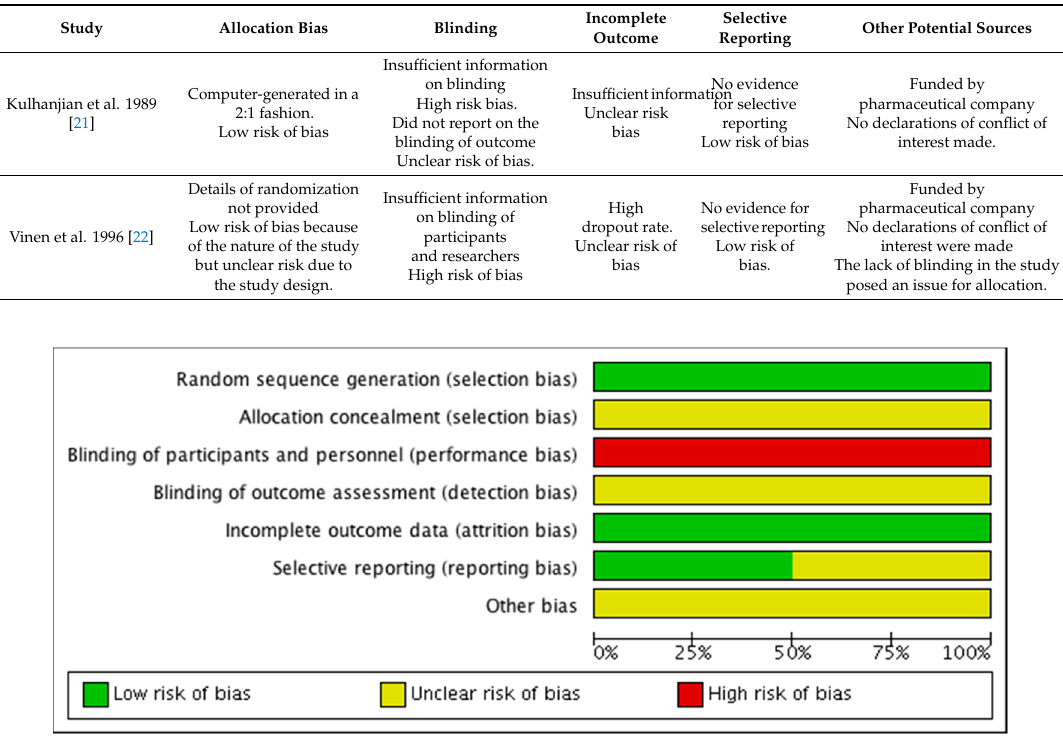
Figure 2. Risk of bias in the randomised controlled trials.